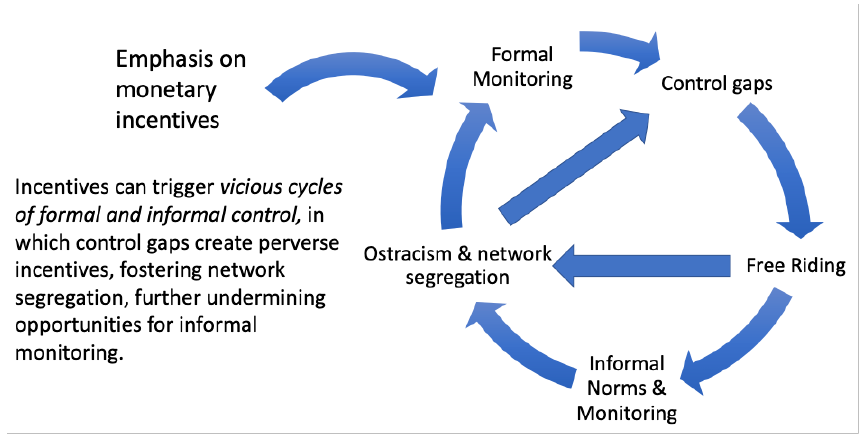
Figure 2: Example for an Incentive